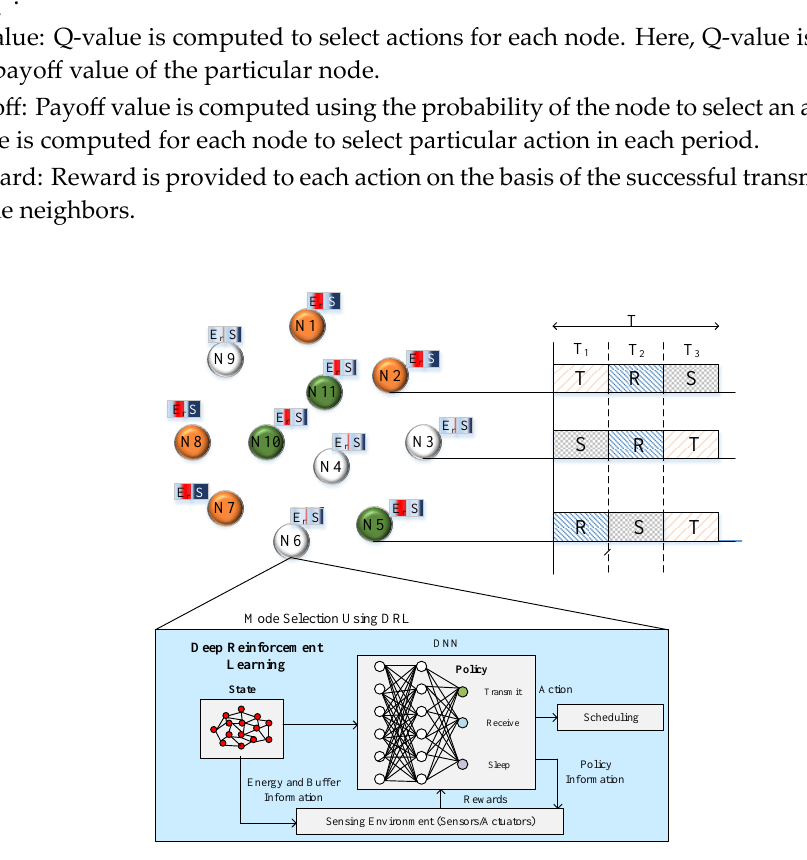
Figure 2. Deep Reinforcement Learning (DRL) scheduling.